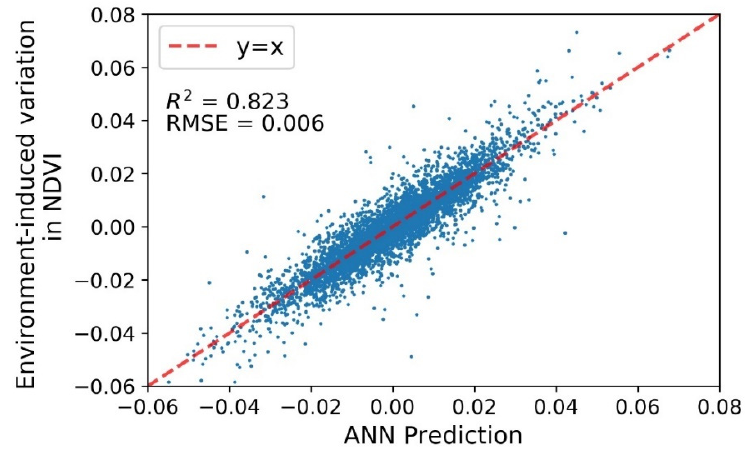
Figure 5. The five-fold cross-validated prediction results of environment-induced variation in NDVI for the sample dataset (G1H). The ANN prediction values show a significant correlation with R 2 = 0.823 and RMSE = 0.006.